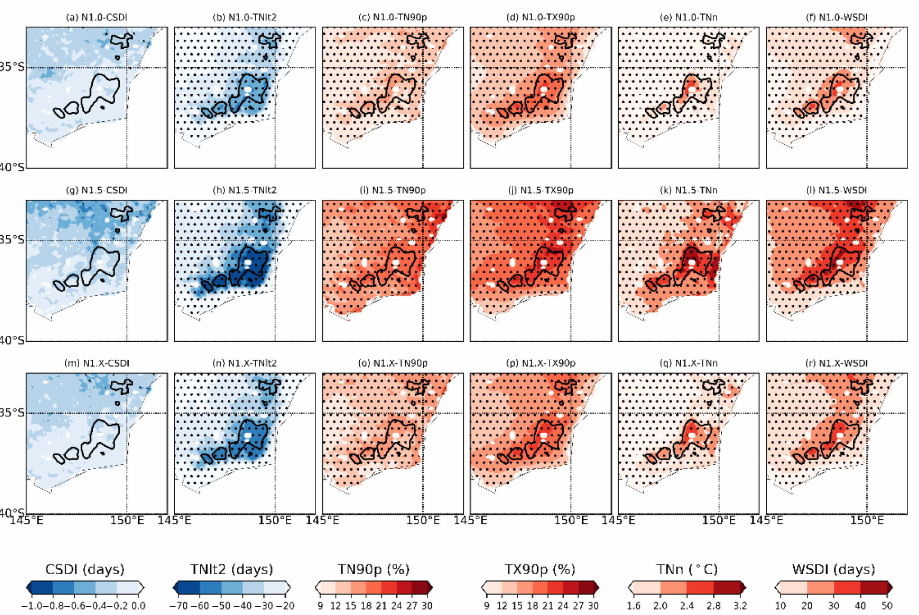
Figure 8. Projected changes in annual CSDI, TNlt2, TN90P, TX90P, TNn and WSDI for N1.0, N1.5 and N1.x for 2060–2079 relative to 1990–2009. Stippling indicates statistically significant changes using a non-parametric Mann-Kendall test at the 95% confidence level. The black solid lines are the 1200 m contour where the high elevation areas